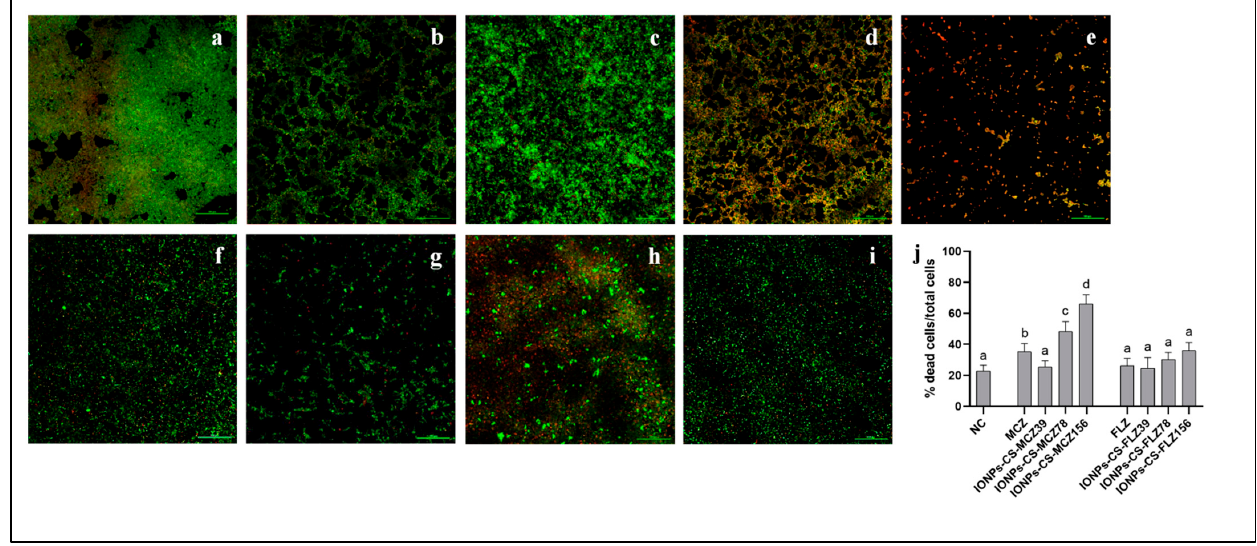
Figure 2. Confocal laser scanning microscopy images of 48 h mixed biofilms of Candida albicans , Candida glabrata , and Candida tropicalis treated (24 h) with miconazole (MCZ) at 156 µg/mL ( b ), chitosan (CS)-coated iron oxide nanoparticles (IONPs) carrying MCZ at 39 ( c ), 78 ( d ), and 156 µg/mL ( e ), fluconazole (FLZ) at 156 µg/mL ( f ), and FLZ-containing nanocarrier at 39 ( g ), 78 ( h ), and 156 µg/mL ( i ). Biofilm grown for 72 h in artificial saliva devoid of drugs depicts the negative control (NC; a ). Dead and living cells are represented by red and green fluorescence, respectively. Magnification: 20×. Bars: 100 µm. The percentages of dead cells after treatment with each compound are shown in image “ j ”. Distinct lowercase letters depict significant differences among the groups within each drug (one-way ANOVA and Fisher LSD’s test; p < 0.05). Statistical analysis was conducted separately for each antifungal agent, its nanocarriers, and negative control.